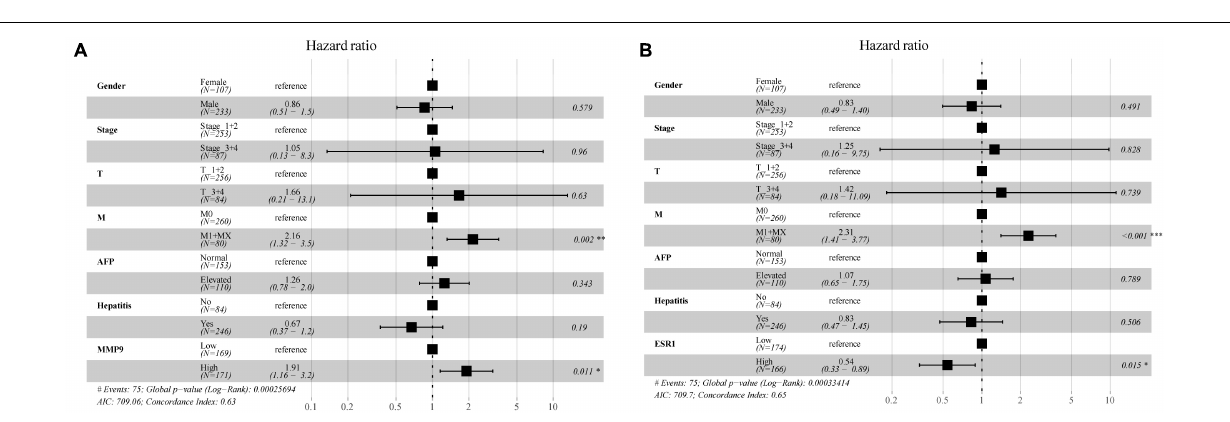
FIGURE 8 | Multifactorial Cox analysis of MMP9 and ESR1 expression in hepatocellular carcinoma (HCC) patients. (A) The results of multifactorial Cox analysis suggested that MMP9 gene was an independent risk factor for the prognosis of HCC patients. (B) The expression of the ESR1 gene was an independent protective factor for the prognosis of HCC patients. * p < 0.05; ** p < 0.01; *** p <